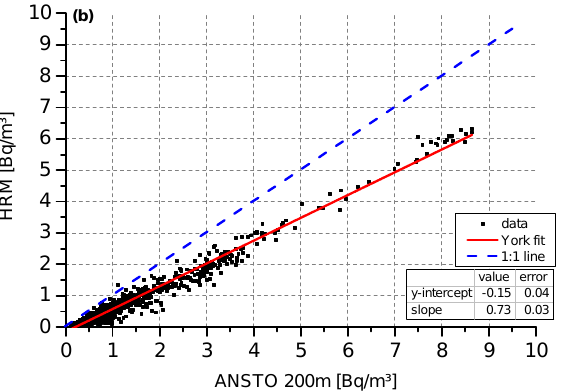
Figure 3. Results from the line test experiment at Cabauw tower. (a) shows 222 Rn activity concentrations measured with the ANSTO system on air collected from the 200m platform (red line), but cor- rected by a factor of 1 / 1 . 11 (see text) in comparison to the HRM 214 Po measurements on air from the 180m level of the tower col- lected through a 200m Decabon tubing (black line). (b) shows the scatter plot of the two records with a geometric mean regression line (York et al., 2004) yielding a slope of